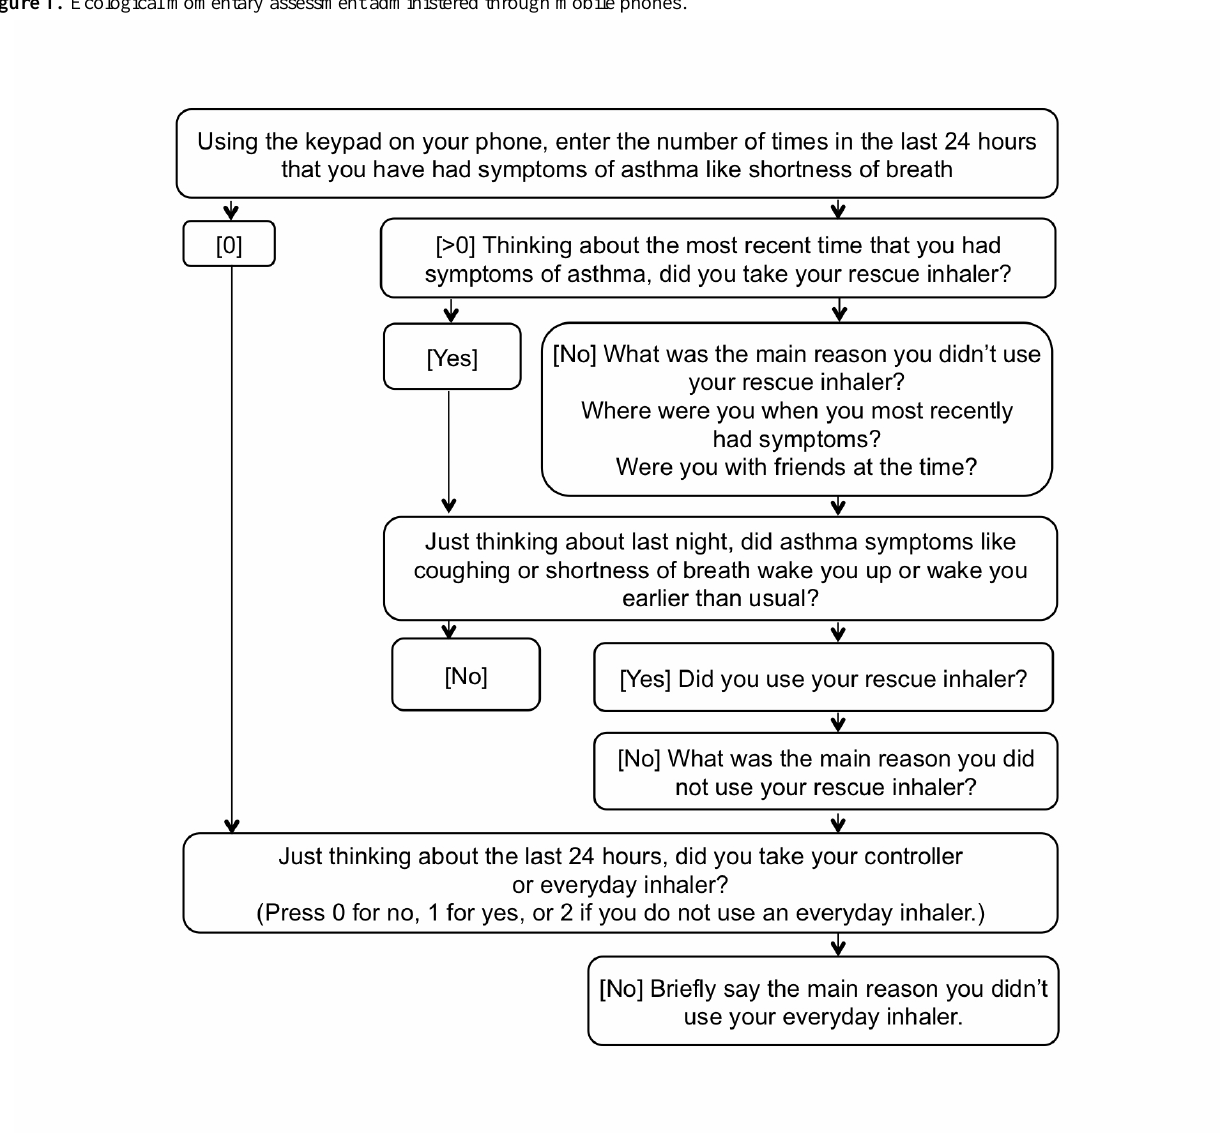
Figure 1. Ecological momentary assessment administered through mobile